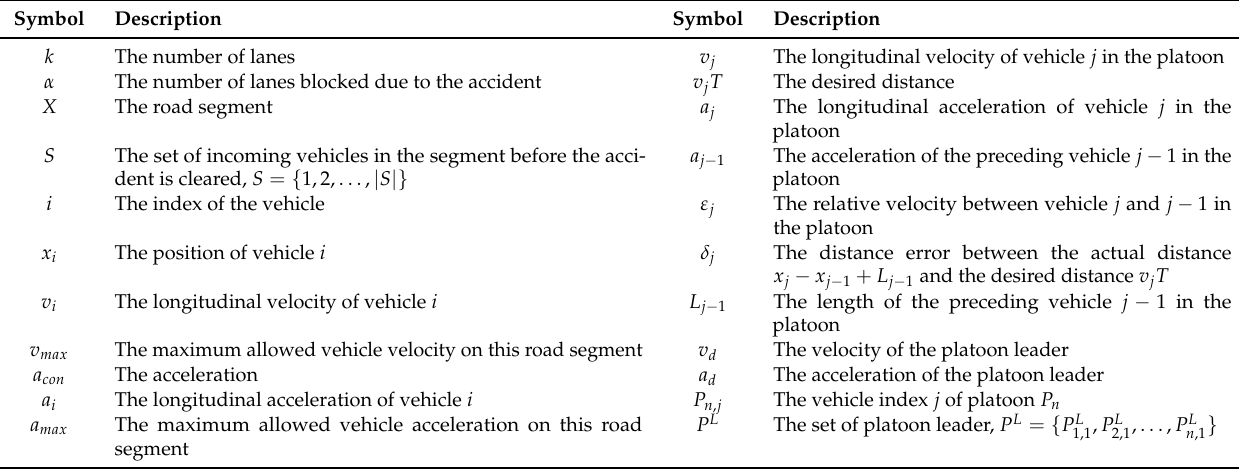
Table 1. Notation used in this